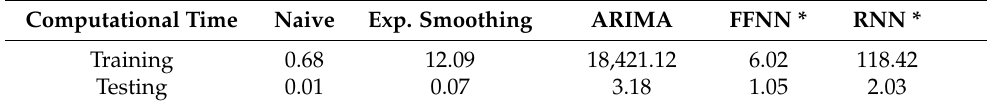
Table 5. Training and testing time in